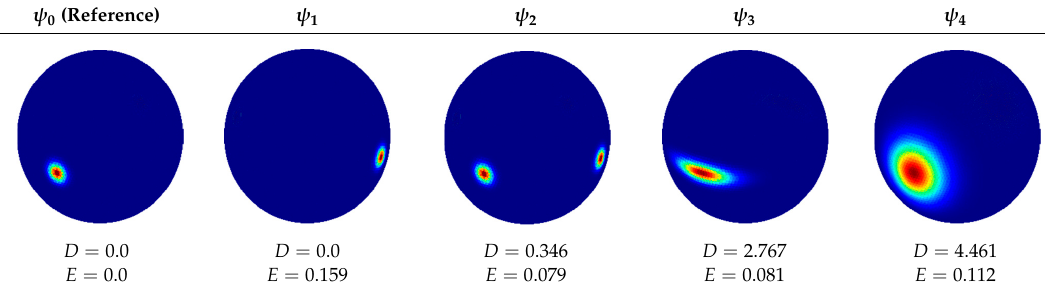
Table 5. Comparison of ODFs (with ψ 0 ) for the illustration of evaluation criteria. Table 5. Comparison of ODFs (with ψ Table 5. Comparison of ODFs (with ψ (cid:2868) ) for the illustration of evaluation criteria. Table 5. Comparison of ODFs (with ψ (cid:2868) ) for the illustration of evaluation criteria. Table 5. Comparison of ODFs (with ψ (cid:2868) ) for the illustration of evaluation criteria. Table 5. Comparison of ODFs (with ψ (cid:2868) ) for the illustration of evaluation criteria. (cid:2868) ) for the illustration of evaluation criteria. 𝝍 𝟎 (Reference) 𝝍 𝟎